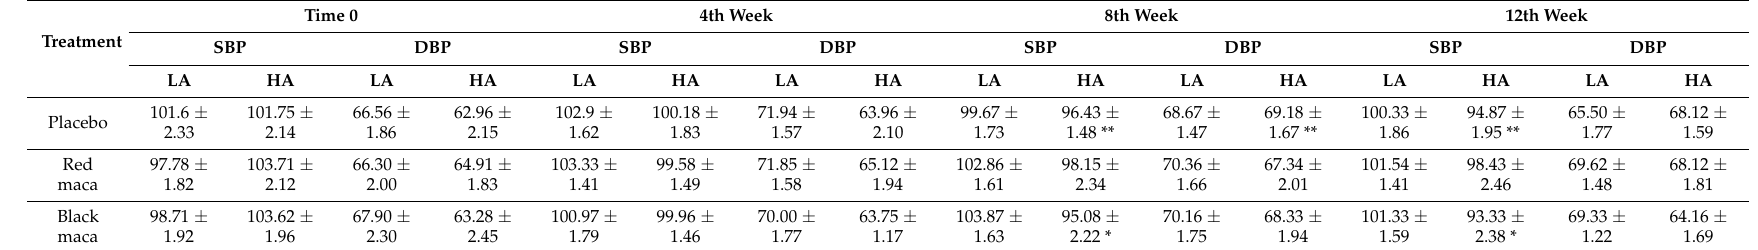
Table 3. Systolic and diastolic arterial pressure of subjects who consumed maca or a placebo at low and high